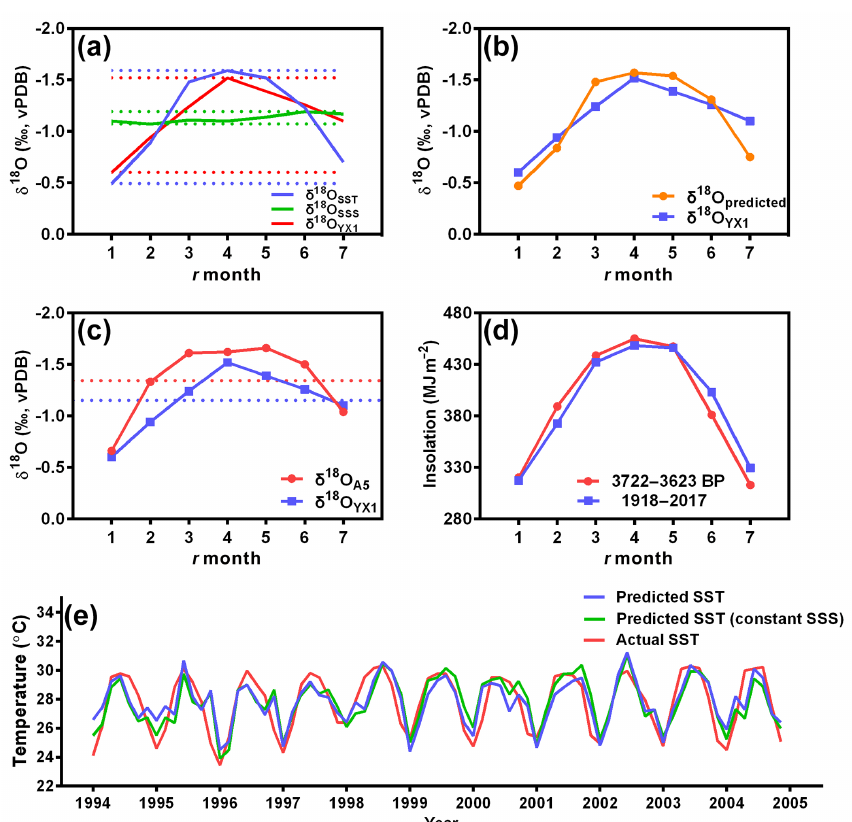
Figure 4. (a) Predicted r -monthly δ 18 O profiles under constant SSS (blue line) and constant SST (green line) conditions, and δ 18 O of YX1 (red line). Dotted lines represent the maximum and minimum of the r -monthly δ 18 O profiles. (b) r -monthly δ 18 O YX 1 and δ 18 O predicted . The (c) r -monthly δ 18 O YX 1 and δ 18 O A5 , and the dotted lines represent mean values. (d) Different insolation 3700 years ago and in the past 100 years. (e) Mean seasonal cycles of reconstructed SST A5 and North Reef SST. (f) Different SST profiles: predicted SST with varied SSS (blue line), constant SSS (green line), and actual SST (red line),